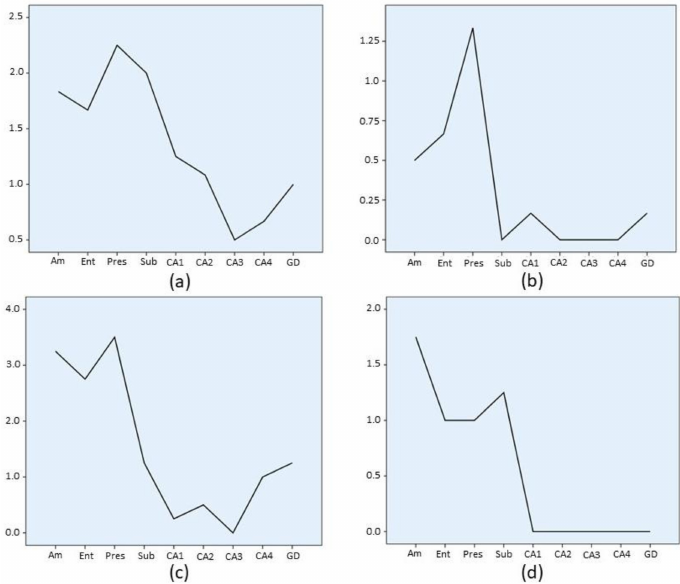
Figure 6. Lesion profile of average involvement (Ai) intensity along the medial temporal lobe in genetic and acquired forms of human prion disease (HPD). Note the different scale range of single charts. ( a ) Familial CJD; ( b ) fatal familial insomnia; ( c ) iatrogenic CJD; and ( d ) variant CJD. Am : amygdala; Ent : entorhinal cortex; Pres : presubiculum; Sub : subiculum; CA1 , CA2 , CA3 and CA4 : CA Sommer’s sectors of the hippocampus; GD : dentate